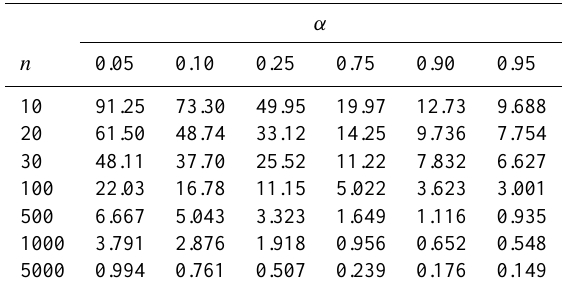
Table 1. Critical values of the PPCC test statistic for λ = 0. Re- ported values are 1000(1 − r